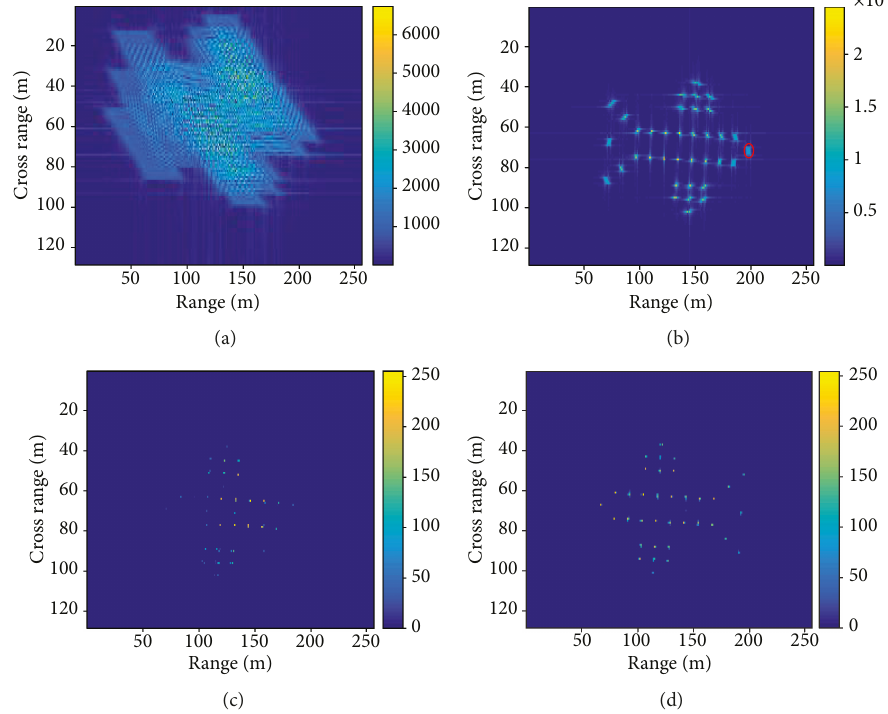
Figure 10: Imaging results with the target ’ s motion parameters P6. (a) RD algorithm. (b) Minimum entropy method. (c) OSS phase retrieval algorithm. (d) The proposed